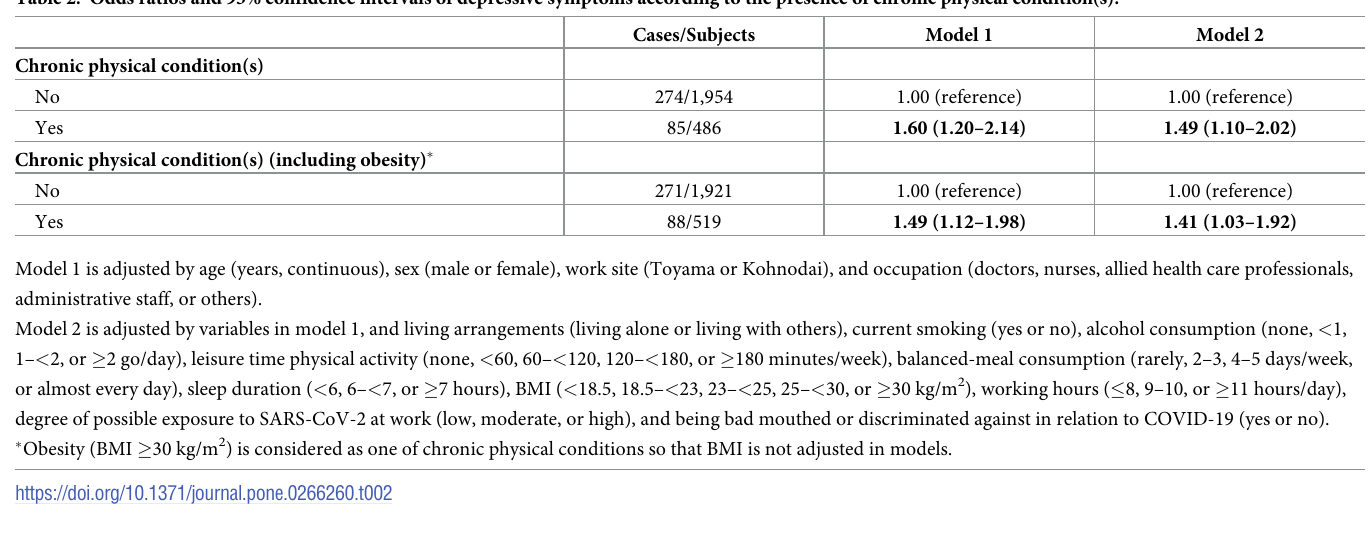
Table 2. Odds ratios and 95% confidence intervals of depressive symptoms according to the presence of chronic physical